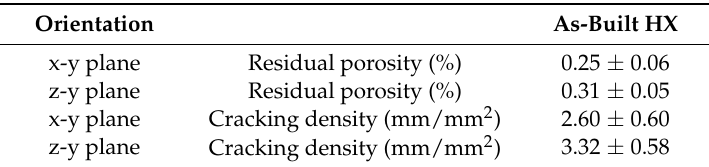
Table 2. Residual porosity and cracking density of as-built HX samples along different orientations.